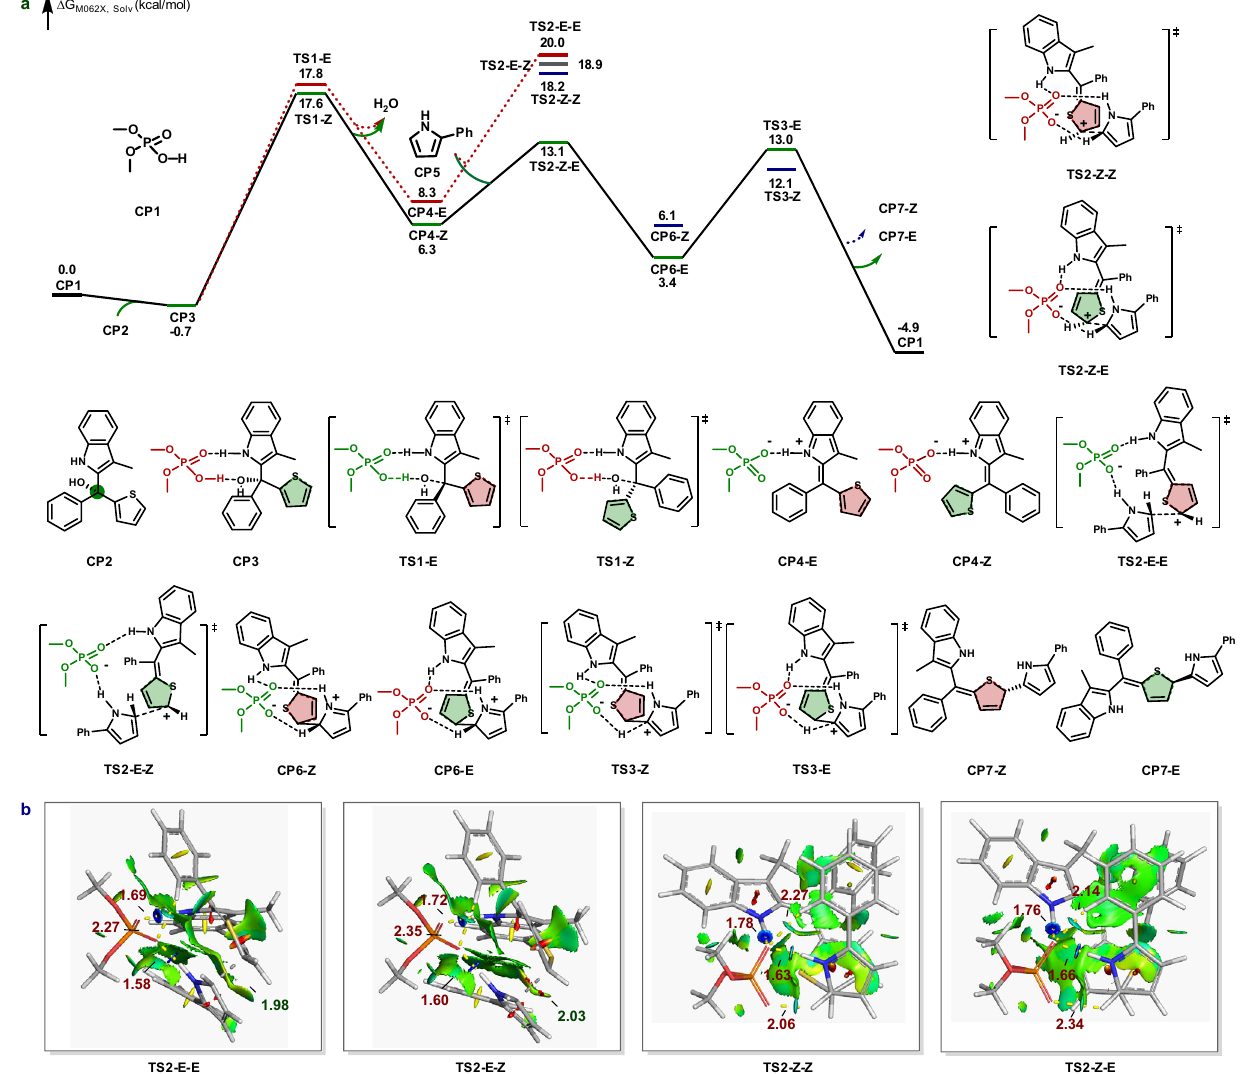
Fig. 3 DFT calculations for the enantioselective dearomatization of thiophenes. a Free energy pro fi le of dimethyl phosphoric acid-catalyzed dearomatization of thiophenes. b Color- fi lled NCI isosurfaces of the transition state TS2-E-E , TS2-E-Z , TS2-Z-Z , and TS2-Z-E (blue, strong attraction; green, weak interaction; red, steric effect). The distances are given in Ångstroms.